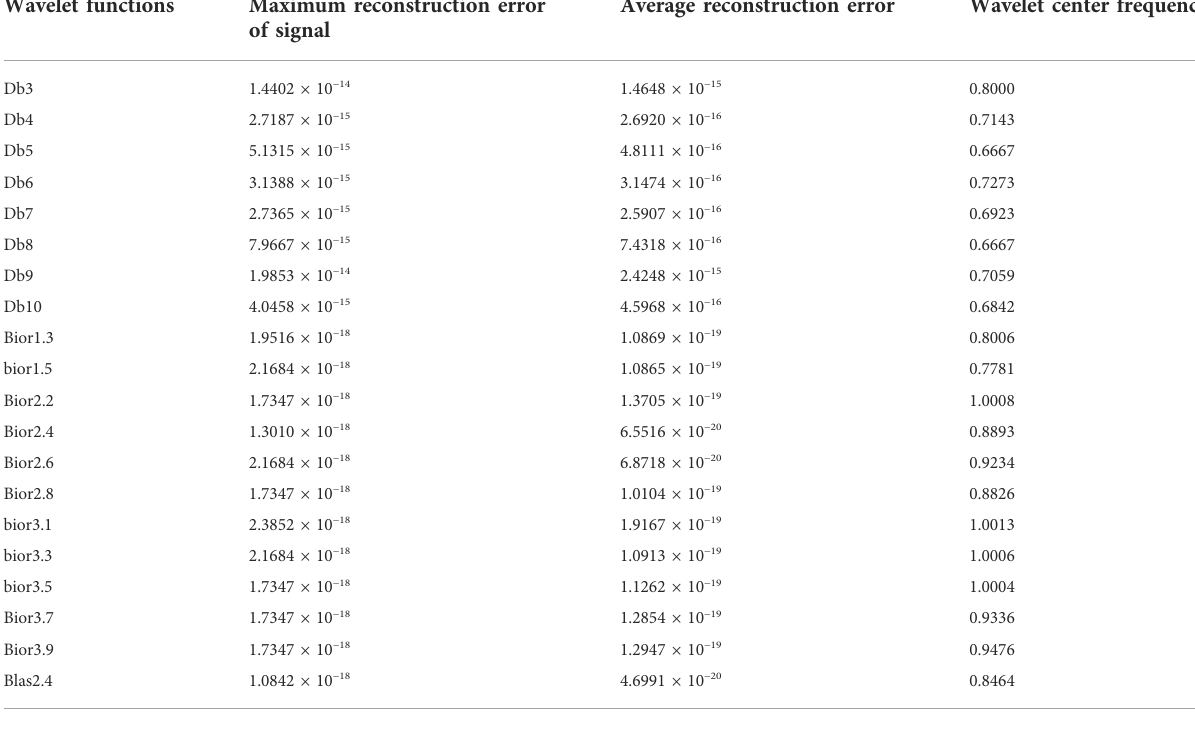
TABLE 1 Signal reconstruction error and center frequency of different wavelet basis.